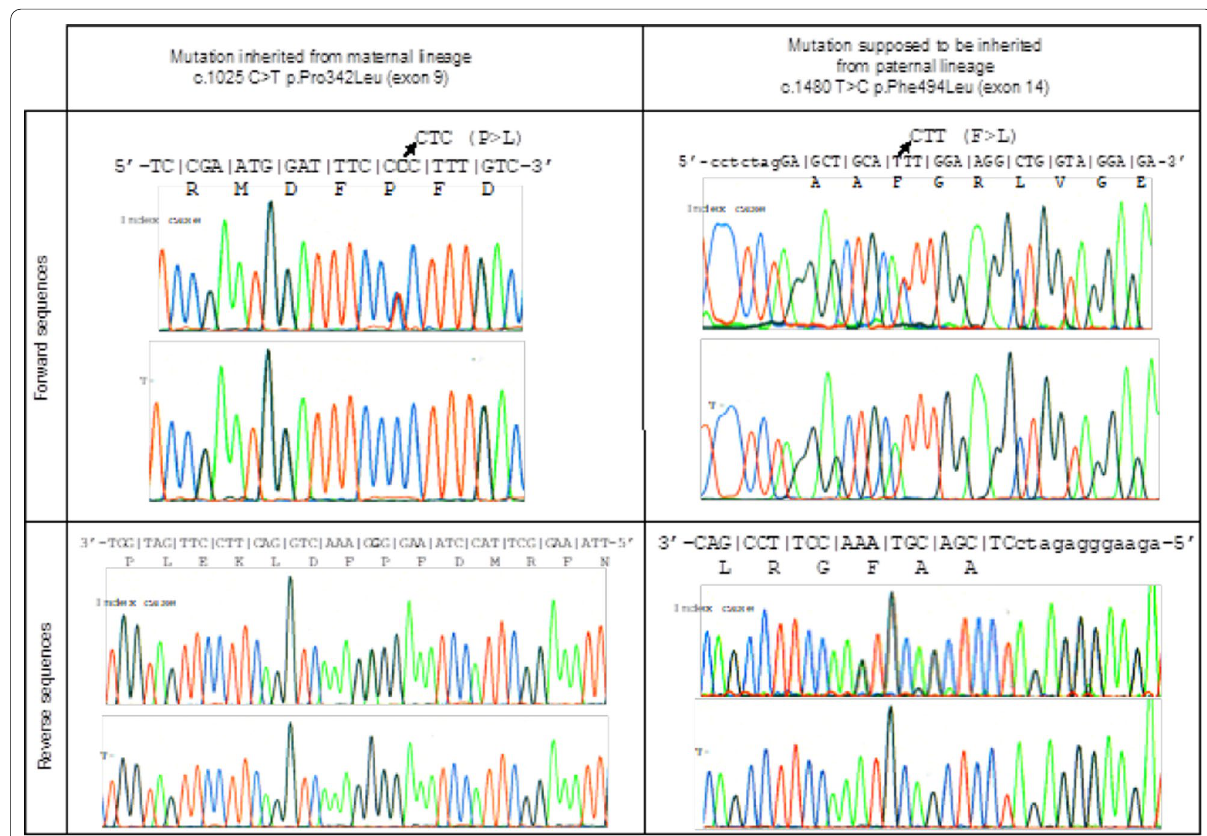
Fig. 6 Electrophoregrams showing the two heteroallelic CLCN1 missense mutations detected in index case as well as her two affected